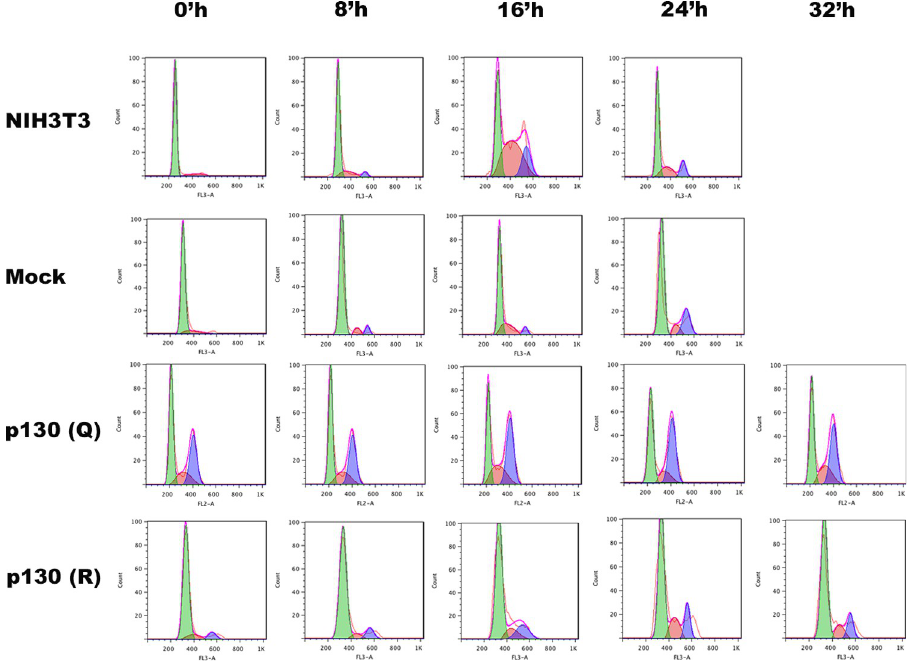
Fig 6. FACS analysis of NIH3T3 cells stably expressing wildtype Rbl2 and K1083 mutated forms. Different cell cycle stages are marked with different colors. Cells in G1 are shown in green, S-phase cells are marked with pink, and G2/M phase cells are colored